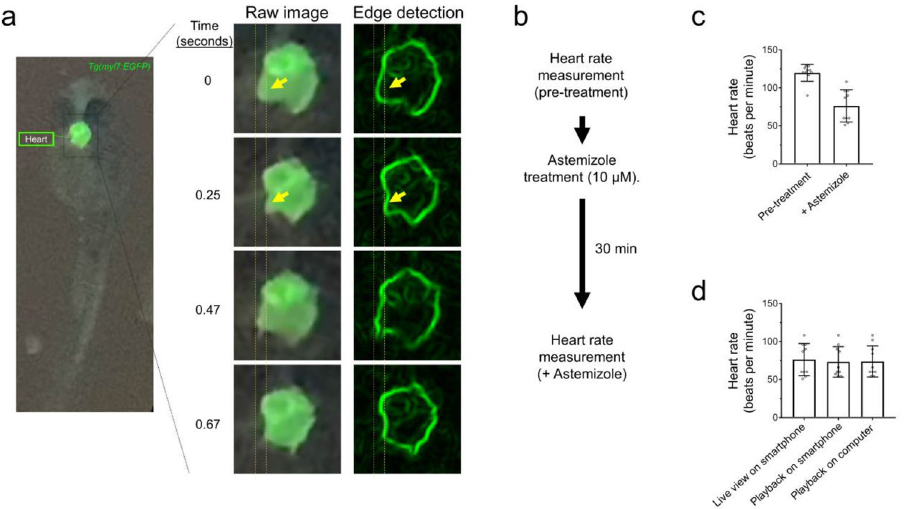
Figure 5. Glowscope detection of drug-induced changes to heart rate in transgenic zebrafish embryos. ( a ) Left fluorescence image shows GFP expression in the heart of a Tg(myl7:EGFP) embryo (ventral view). The boxed region is further magnified in the middle column, which from top to bottom show chamber movements across a video acquired on an iPhone 11 Pro smartphone. To aid viewing of chamber movements, these videos were transferred to a laptop, opened in ImageJ (free software), and processed using edge detection, which outlines the walls of the chambers. Static arrows highlight heart chamber movements. ( b ) Flow chart of the pre- and post-imaging of zebrafish heart rate in response to astemizole treatment (10 µM). ( c ) Plots show the average heart rate of zebrafish embryos prior to and after treatment with astemizole. n = 10 animals measured in one independent experiment, P = 0.0002, paired two-tailed t-test. ( d ) Summary of measurements conducted while recording the video in real time (left bar), viewed on the smartphone after recording the video (middle bar), or viewed on a laptop (right bar). N = 10 animals measured in one independent experiment, P = 0.942, one-way ANOVA. For panels ( c–d) , scatter plot points represent individual zebrafish (heart) rate measurements and error bars represent standard